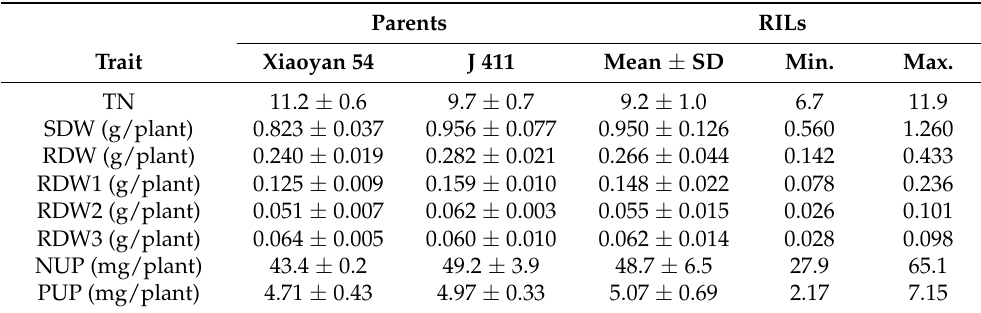
Table 1. Mean values and ranges for the investigated traits in the RIL population and their parents at the seedling stage.